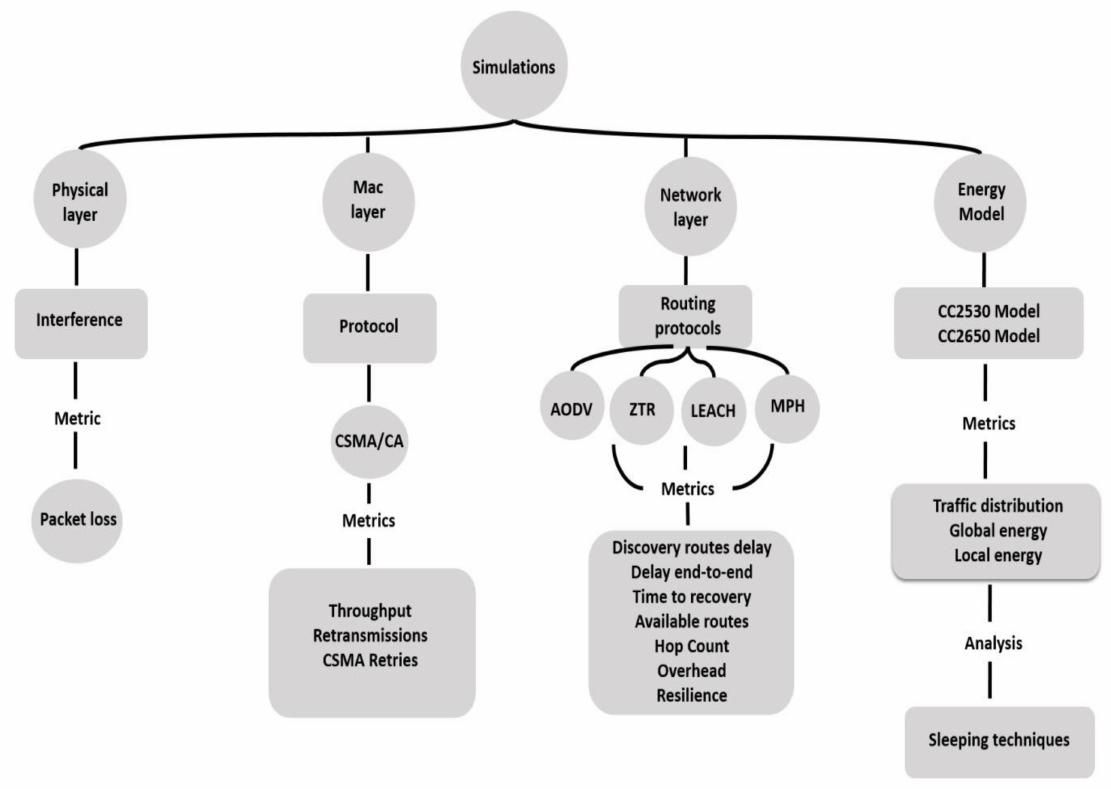
Figure 1. Simulator tool for measuring performance